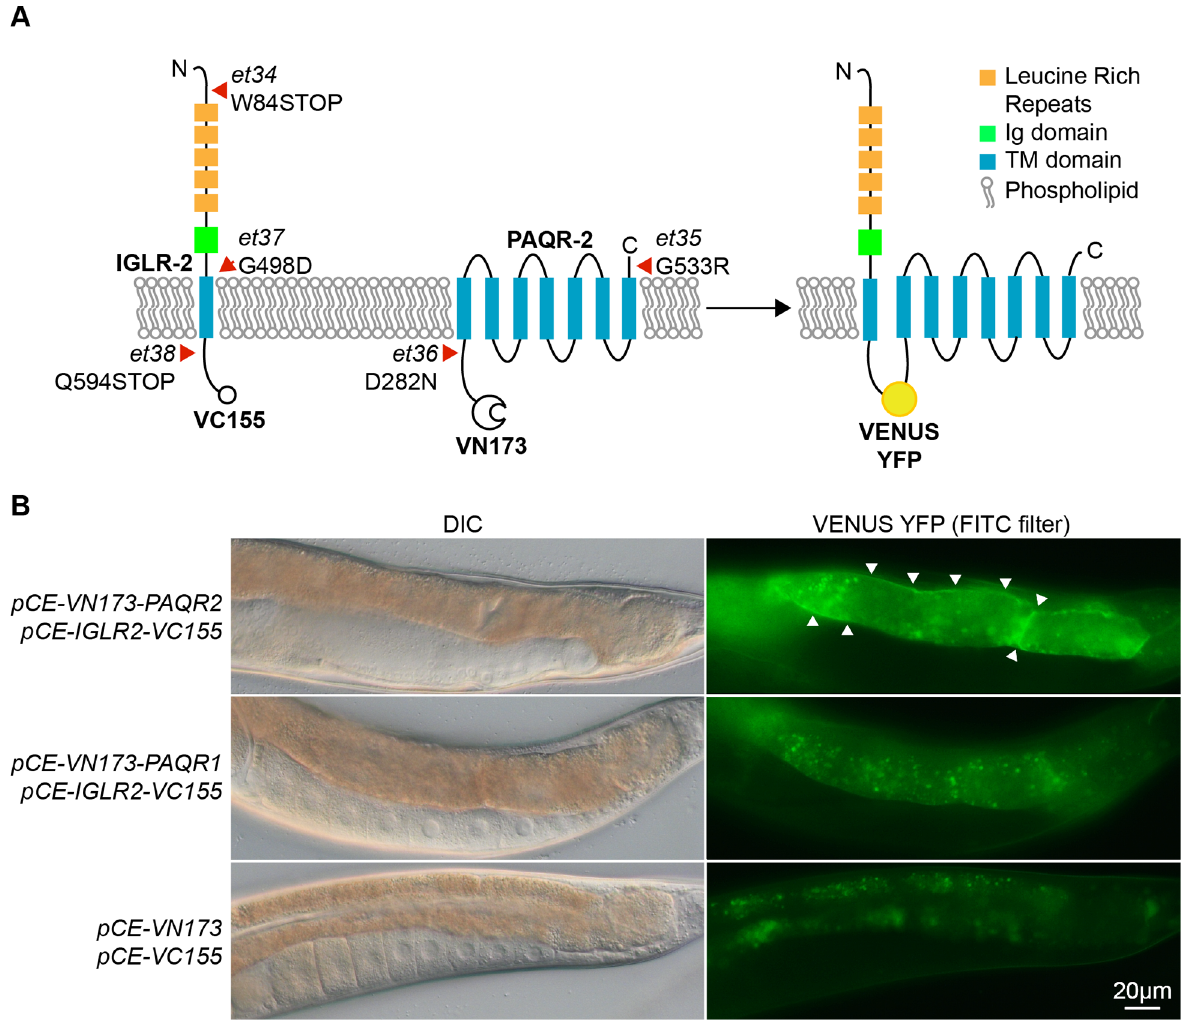
Fig 2. Novel alleles of PAQR-2 and IGLR-2, and interaction of IGLR-2 with PAQR-2. (A) Schematic structures of the IGLR-2 and PAQR-2 proteins, with novel mutations indicated by red arrowheads. The VC155 and VN173 fragments added to the C and N terminal ends of IGLR-2 and PAQR-2, respectively, allows reconstitution of a full and fluorescent VENUS YFP protein if the two proteins come into close proximity. (B) Result of the BiFC experiment showing that IGLR-2 and PAQR-2 contact each other on cellular membranes. The top two panels show a transgenic worm co-expressing the fusion proteins depicted in (A) ; note the clear membrane-localized fluorescence indicative of IGLR-2 and PAQR-2 interaction. The middle two panels show a transgenic worm co-expressing the tagged IGLR-2 and a tagged PAQR-1 protein; note that only autofluorescent gut granules emit a signal, indicating that IGLR-2 and PAQR-1 do not interact with each other. The bottom two panels show a transgenic animal carrying the two empty vectors used in the BiFC experiments; note again that only autofluorescent gut granules emit a